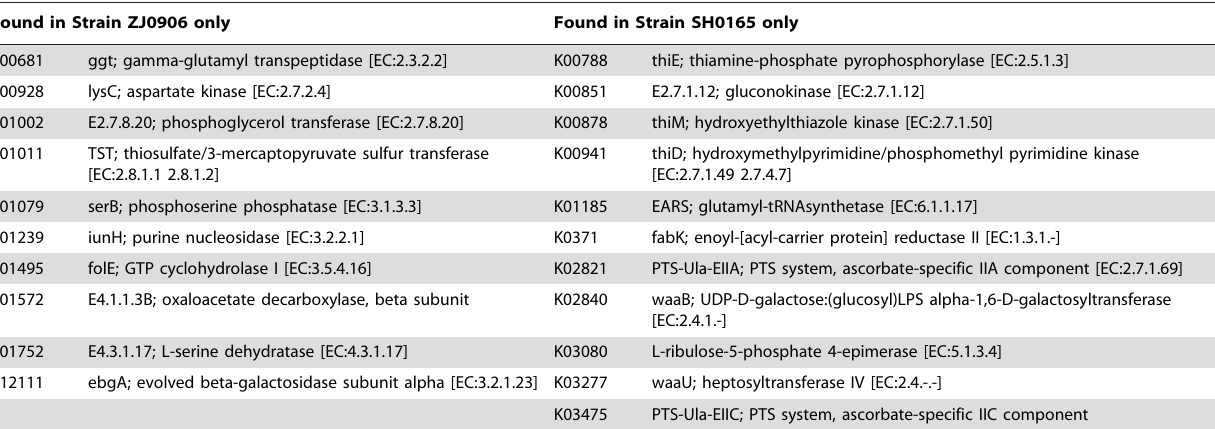
Found in Strain ZJ0906 only Found in Strain SH0165